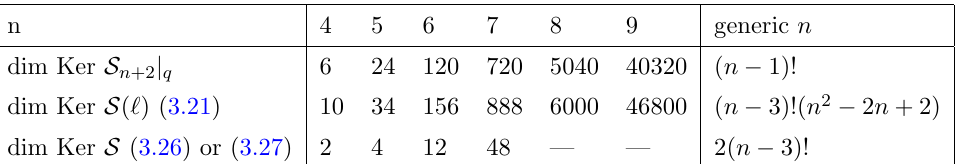
Table 1 . Dimension of the kernel of the momentum kernel at n + 2 points and in the forward limit. The (cid:12)rst line gives the dimension of the kernel before taking the forward limit. We have numerically checked the rank for n = 4 ; 5 ; 6 and 7. Since dim Ker (3.21) = ( n (cid:0) 3)! cannot be more than a quadratic polynomial, three numerical points are enough to con(cid:12)rm the